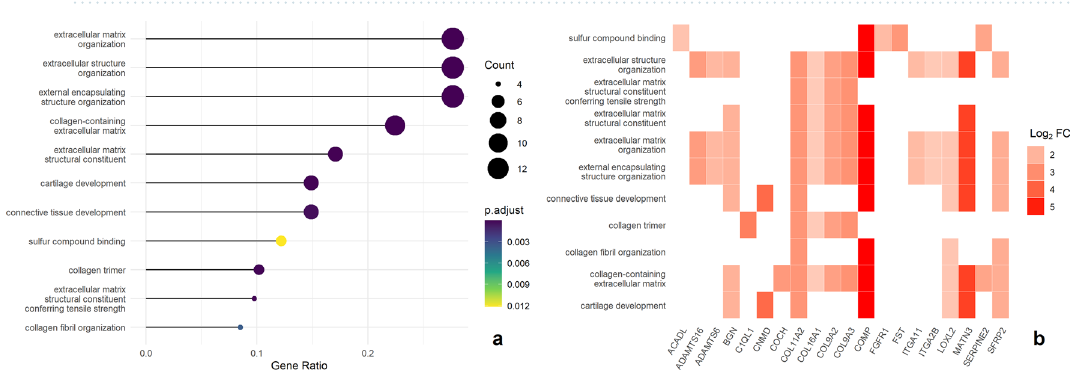
Figure 5. Enriched Gene Ontology terms ( a ) bubble plot for the enriched GO terms ( b ) heatplot for the enriched GO